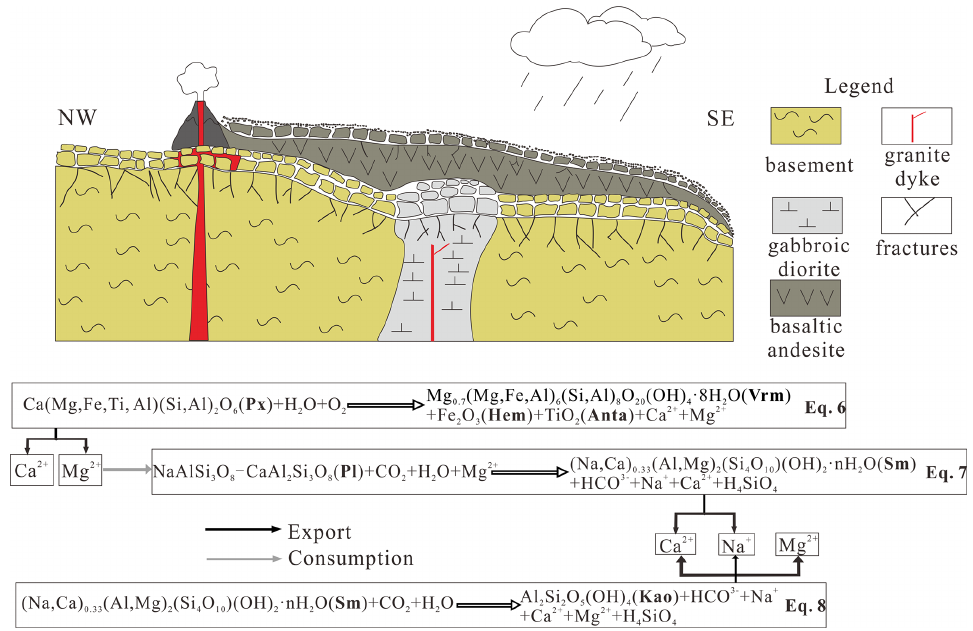
Figure 13. Reconstructed alteration model of the GA1 well in Sprendlinger Horst after volcanic eruption around 290Ma. Px denotes pyrox- ene; other abbreviations are given in the caption of Fig.